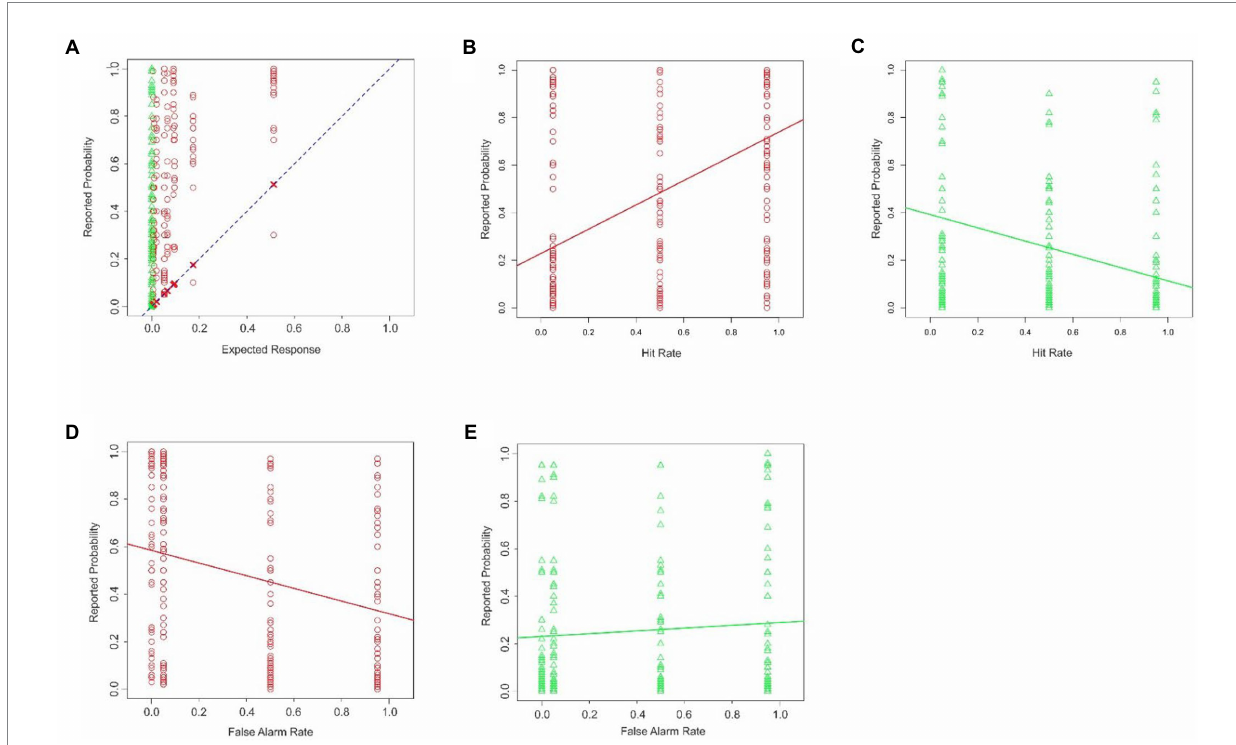
FIGURE 7 Estimation errors in Experiment 4. The data are plotted according to the conventions used in Figure 1. (A) Probability of enemy sniper estimated by subjects is plotted in this Figure as a function of the corresponding theoretically expected probability. (B,C) Interaction between the hit rate and the binary decision of the reconnaissance drone. (D,E) Interaction between the false alarm rate and the binary decision of the drone. See text for